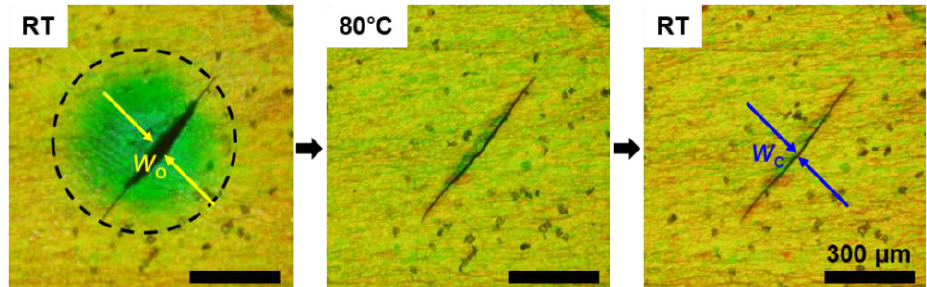
Figure 6. The reflection mode POM images showing the mechanical fracture recovery of the CLC- PUA composite film (20 µ m thick) by the thermal-mediative shape memory effect. A fracture was formed by the compression (black dashed circle) at room temperature, recovered back to the initial state at 80 °C, and remained unchanged from the recovered state as the temperature decreased to room temperature.